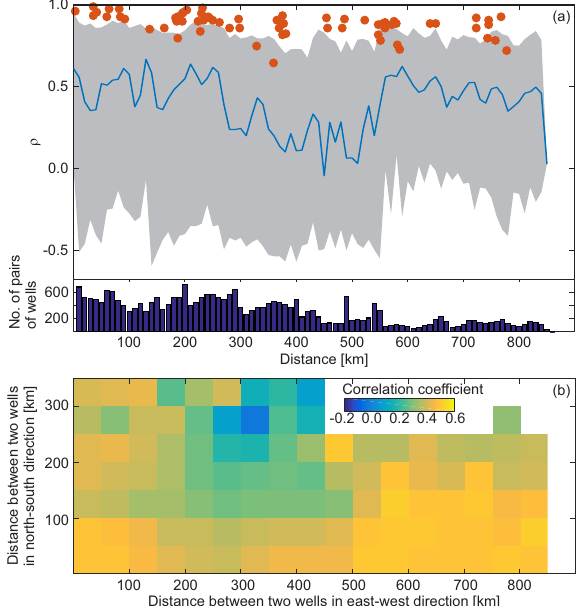
Figure 2. Influence of distance on the correlation between the an- nual means of two measurement points. (a) The correlation between SAT time series is given in red, and the median correlation be- tween GWT time series is given in blue. The inner 90 percentile is coloured in grey, and the number of pairs of wells per distance is shown in dark blue below. (b) The colour gives the median cor- relation between GWTs of two wells in relation to their absolute distance to each other in the east–west direction ( x axis) and in the north–south direction ( y